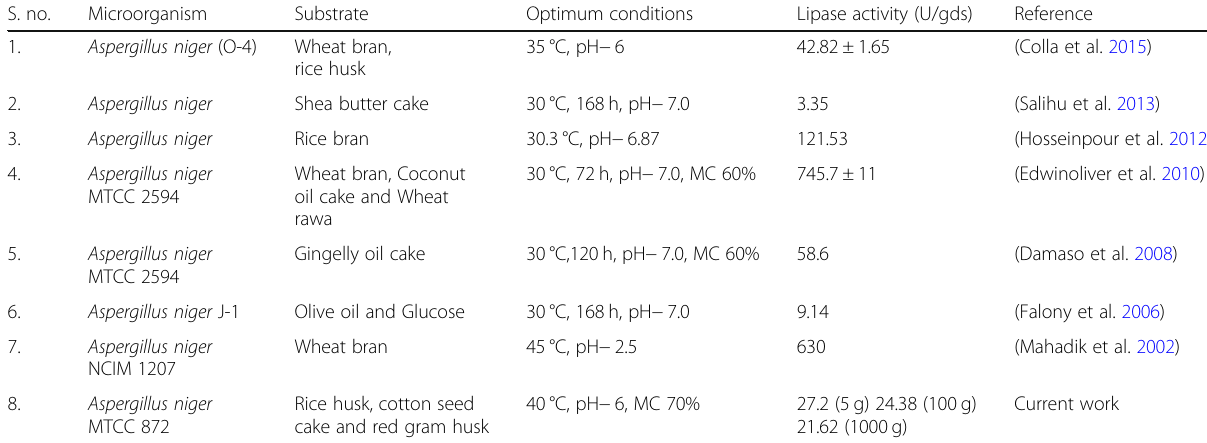
Table 1 Comparison of various works on lipase